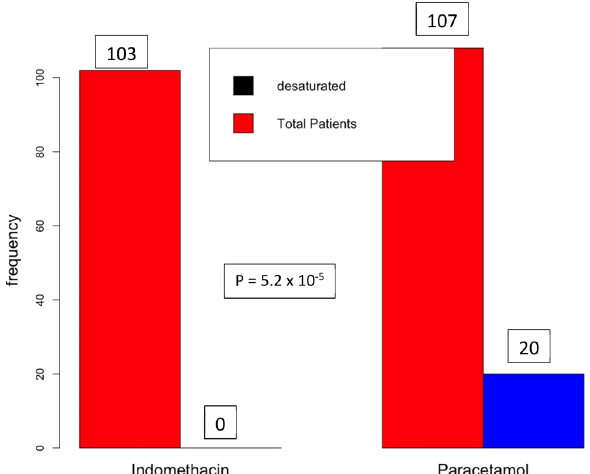
Figure 4. Number of patients desaturated.